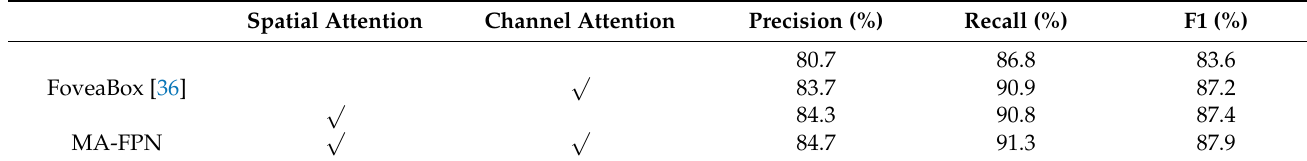
Table 5. Performance of the FPN that incorporates multiple attention mechanisms in RSI.